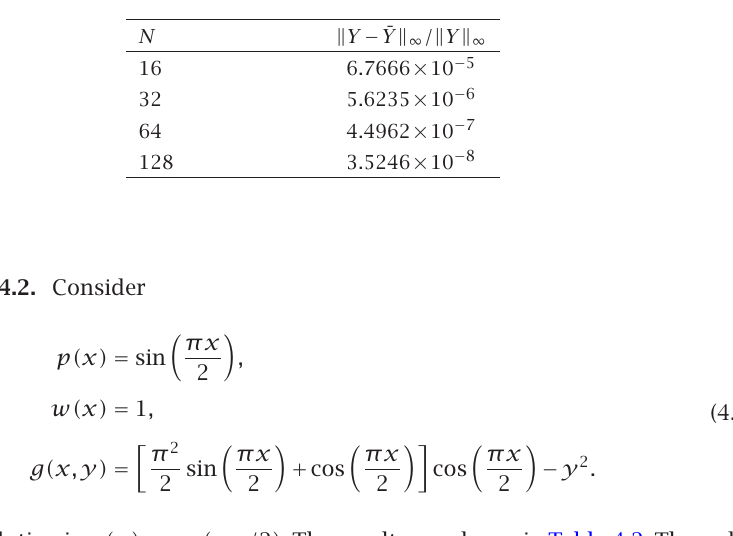
Table 4.1 . The numerical results for Example